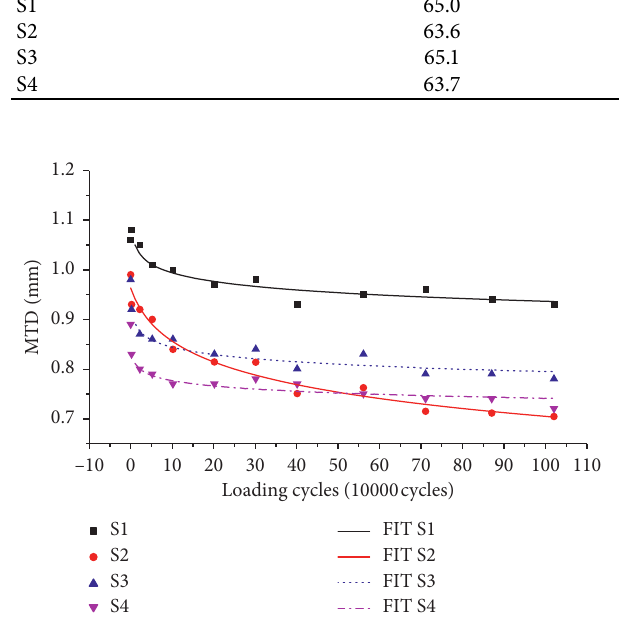
Figure 7: The MTD reduction fitting